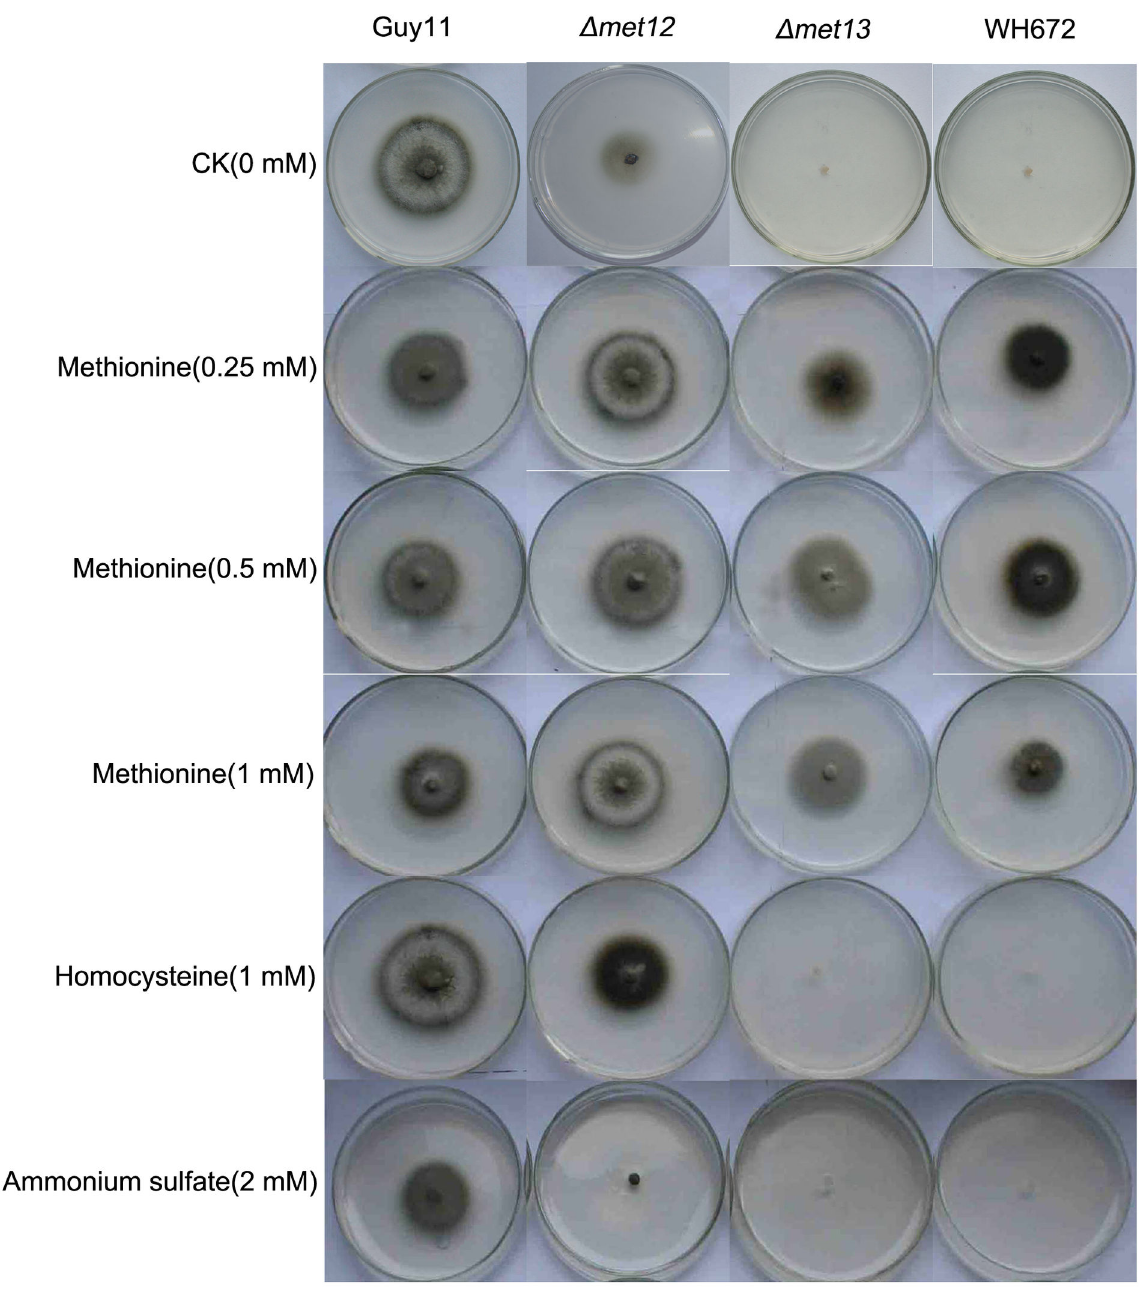
Figure 5. Growth of the wild-type strain and the mutants on MM with methionine, homocysteine or ammonium sulfate. The wild-type strain Guy11, WH672, Δmet13 (K56) and Δmet12 (K12-7) were grown on MM medium at 25°C for 10 days. Concentrations of methionine, homocysteine or ammonium sulfate are as indicated. doi: 10.1371/journal.pone.0076914.g005 MET12 was 4.0 fold up-regulated in both WH672 and Δmet13 carried out quantitative RT-PCR (qRT-PCR) analysis. As mutants (Figure 8). These results are consistent with both expected, gene expression of MET13 was not detected in genes encoding MTHFR and an attempt to restore methionine WH672 and Δmet13 and MET12 was not expressed in the biosynthesis by up-regulation of the alternative gene. Δmet12 mutant (Figure 8). However, expression of MET13 was 1.6 fold up-regulated in the Δmet12 mutant and expression of